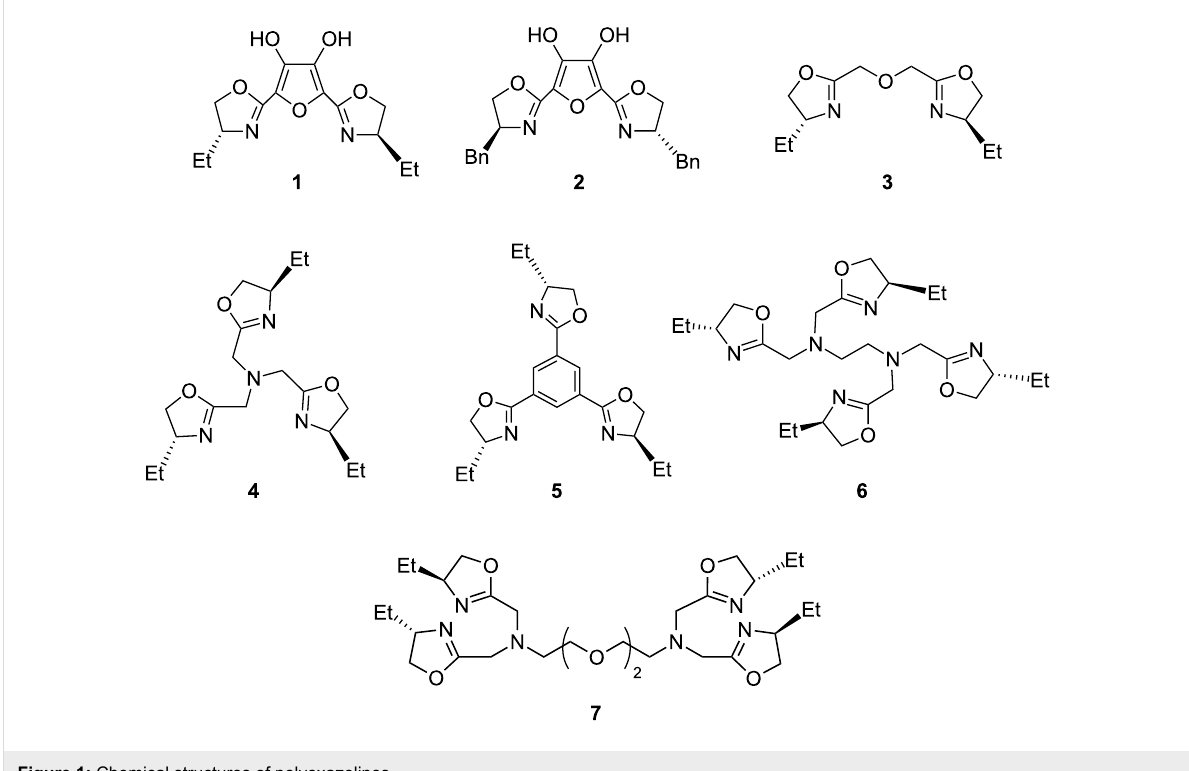
Figure 1: Chemical structures of